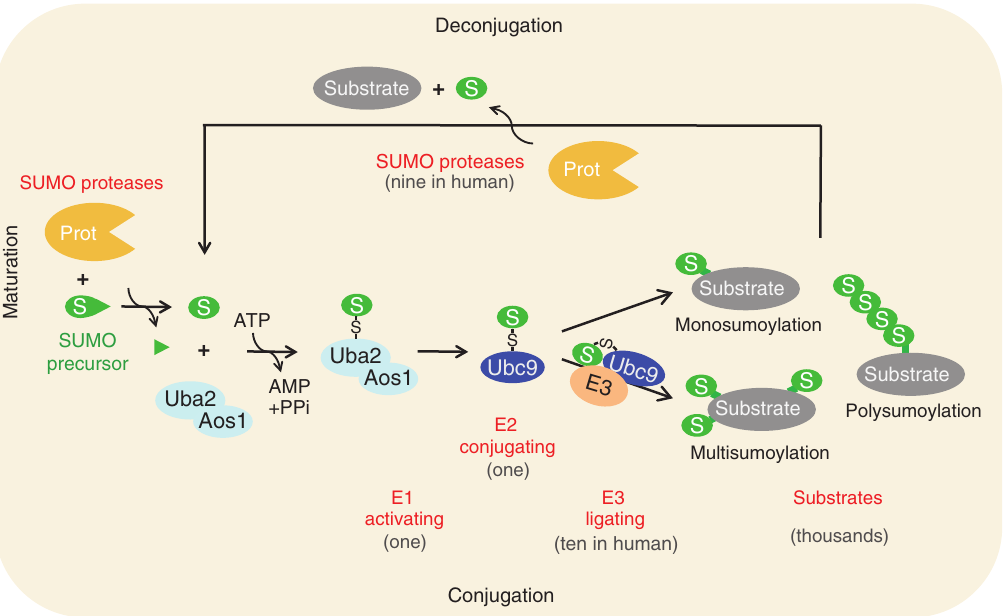
Figure 1: SUMO conjugation